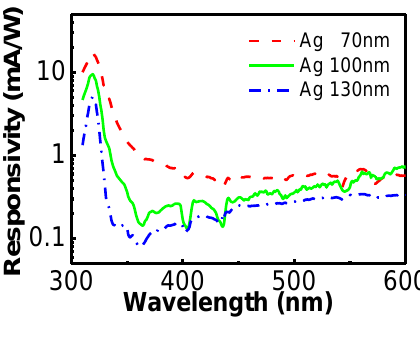
Figure 11. Spectral responsivities of the Ag/SiO thicknesses of Ag. The transmission of UV band at the ~319 nm wavelength was due to the material property of Ag